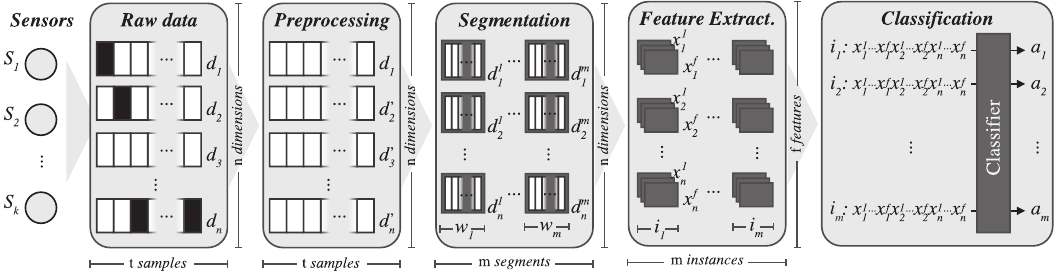
Figure 2. Steps involved in the activity recognition chain (ARC) that range from data collection to